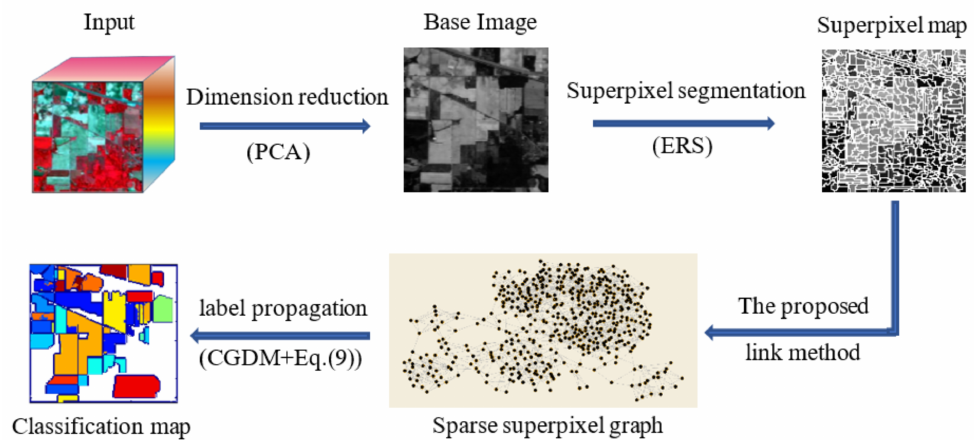
Figure 1. The flowchart of the proposed method. PCA: principal component analysis; ERS: entropy rate superpixel segmentation; CGDM: conjugate gradient descent